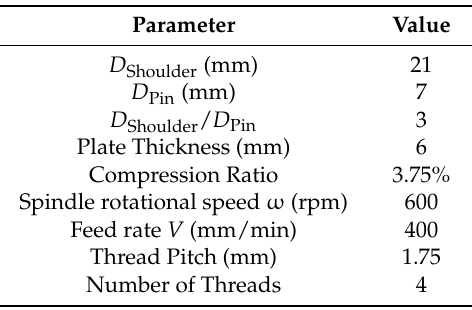
Table 2. Parameters of the welding process for the A6082-T6